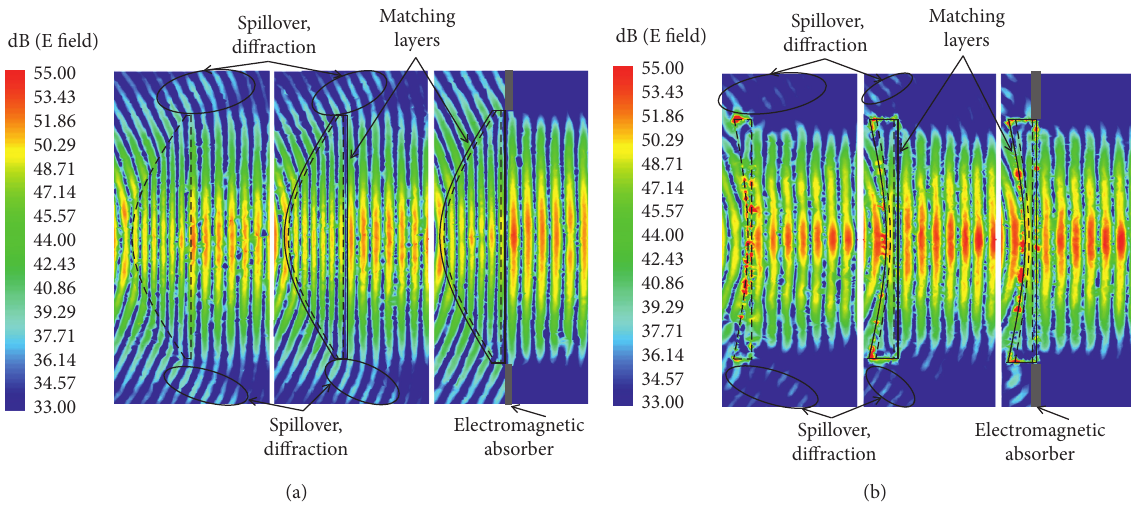
Figure 10: The electric field distributions of lens antennas with and without the quarter wavelength matching layers. (a) PRI lens. (b) NRI lens.